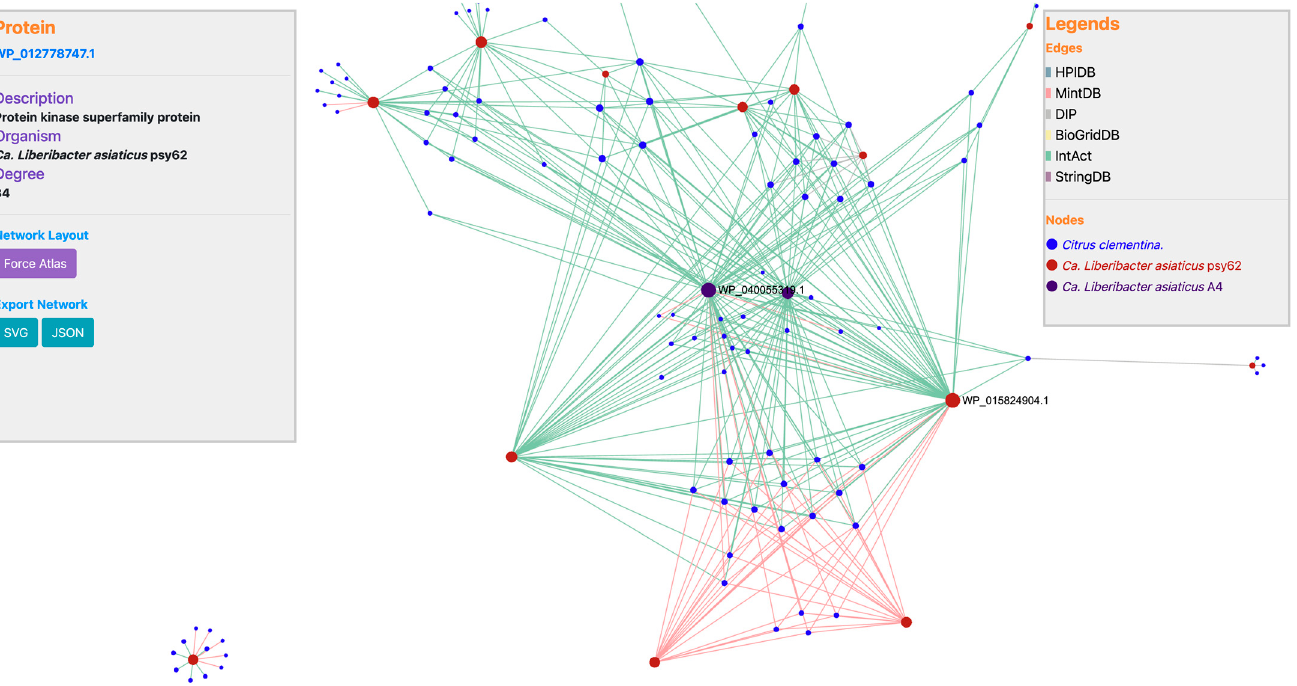
Figure 2. Host–pathogen interaction network visualization obtained through GreeningDB’s comparactomics module. Citrus clementina vs. ‘ Ca . Liberibacter asiaticus’ str. psy62 interactome is compared against Citrus clementina vs. ‘ Ca . Liberibacter asiaticus’ str. A4 interactome.